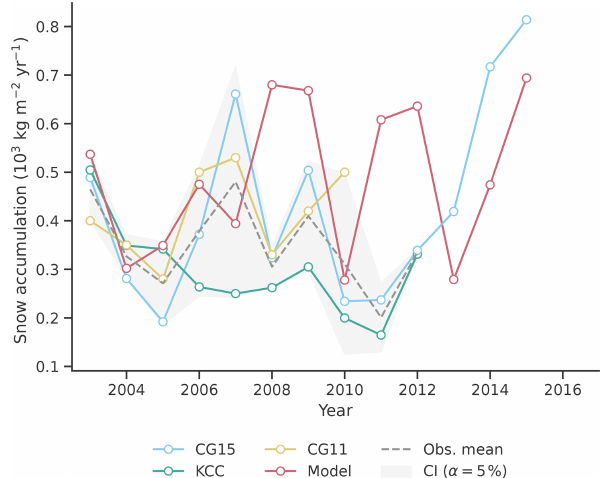
Figure 5. Annual accumulation modelled and retrieved from three ice cores. The average of the annual accumulations from ice cores and its 95% confidence interval are also